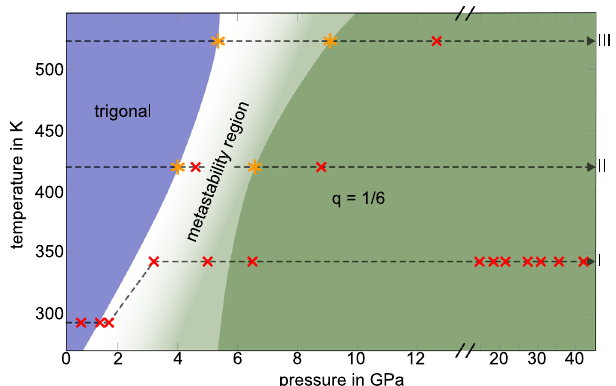
Fig. 3 Pressure-temperature phase diagram of IrTe 2 as deduced from the present x-ray diffraction data. Starting from the trigonal phase without dimers, a metastability region is entered upon increasing pressure. In this region, different ordered phases appear and sometimes coexist. With further increasing pressure, the long-rangedordered q = 1/6-phase isreached, which remains stable up to 42GPa. Three samples have been measured at different temperatures as a function of increasing pressure, as indicated by the dashed paths I, II, and III. Red crosses indicate points where full single crystal diffraction data sets have been recorded. Orange stars indicate points where the phase boundary has been observed in an overview scan, i.e., one detector image recorded during a ω -rotation over ±31 ∘